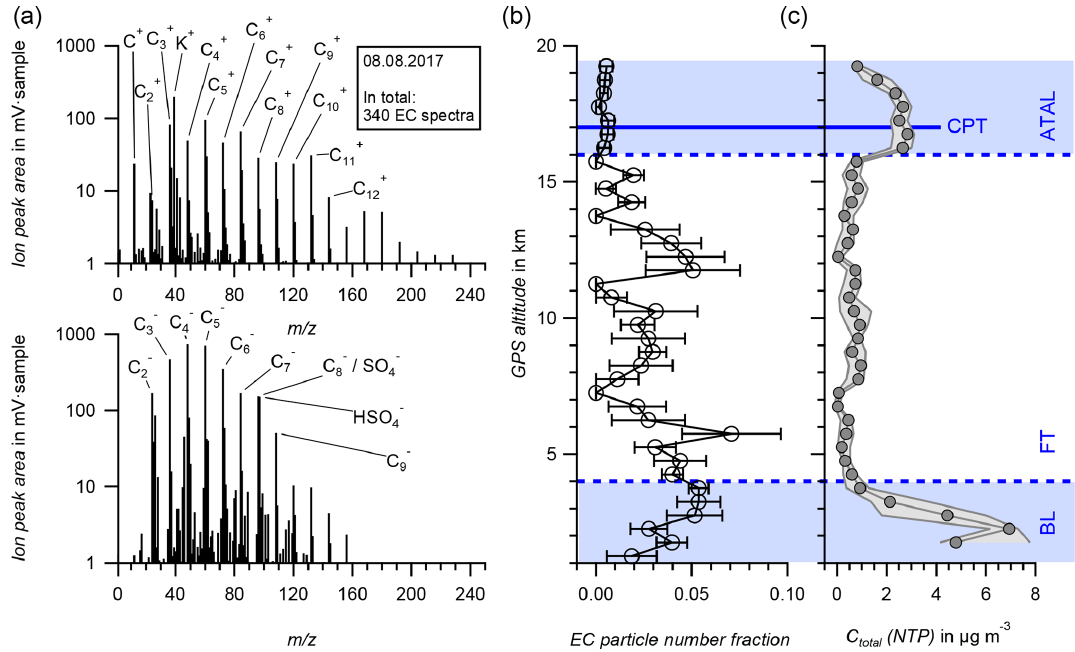
Figure 16. Data from the research flight on 8 August 2017 during StratoClim, Nepal. The vertical resolution is in altitude bins of 500m. The horizontal blue line marks the cold-point tropopause (CPT). The Asian tropopause aerosol layer (ATAL), the free troposphere (FT) and the boundary layer (BL) are indicated. (a) The mean mass spectrum of 340 EC-containing single particles. (b) The vertical profile of the particle number fraction of EC-containing single particles (ERICA-LAMS). The uncertainty in the particle number fraction is calculated from counting statistics. (c) The vertical profile of the median total mass concentration C total (NTP; ERICA-AMS). The interquartile range of the median total mass concentration C total is shaded in